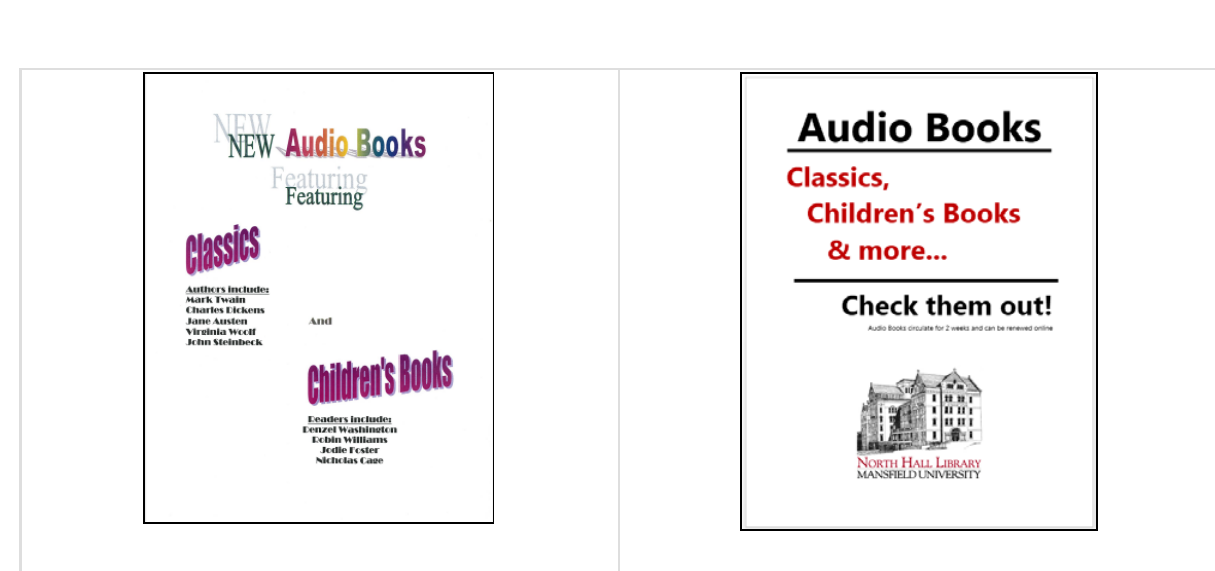
The original sign (left) uses Word Art, a difficult-to-read font, and text shadows. It is hard to read even from up close. The new simplified design (right) is easy to read from a distance. The non-traditional alignment is an attempt to break away from centering everything.